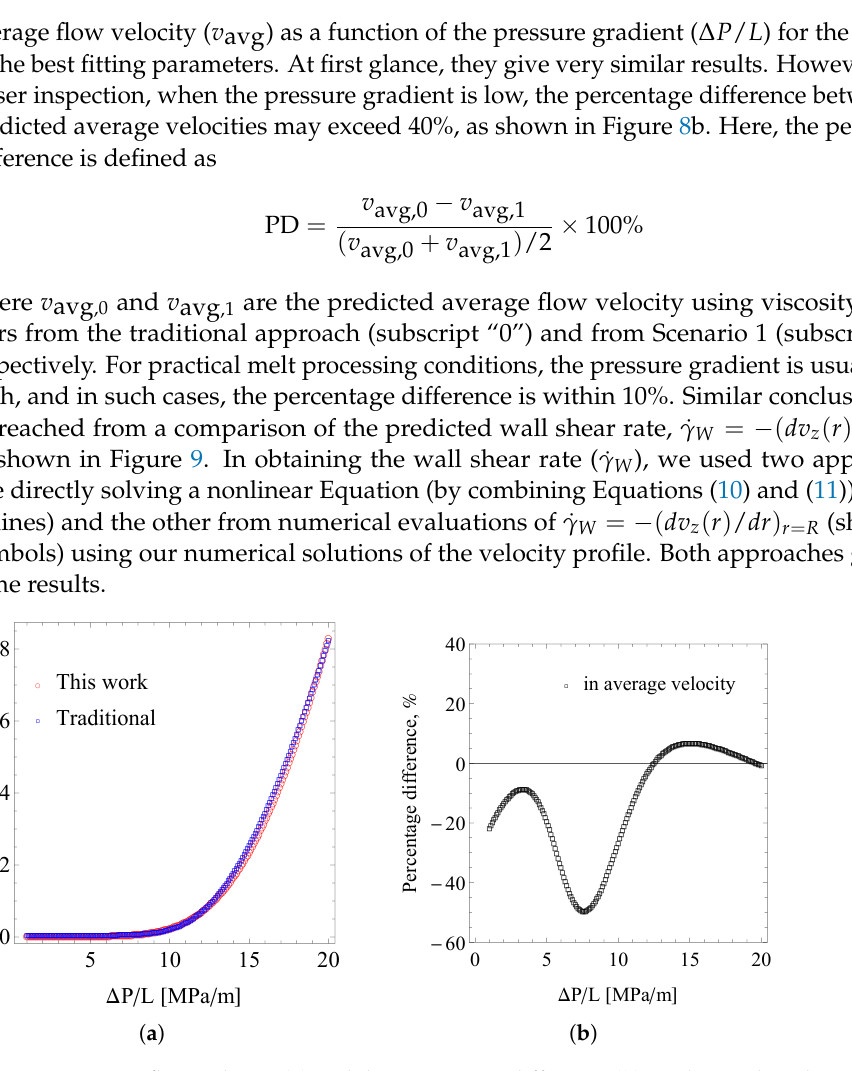
Figure 8. Average flow velocity ( a ) and the percentage difference ( b ) on the predicted average flow velocity. Tube radius R = 0.05rm.